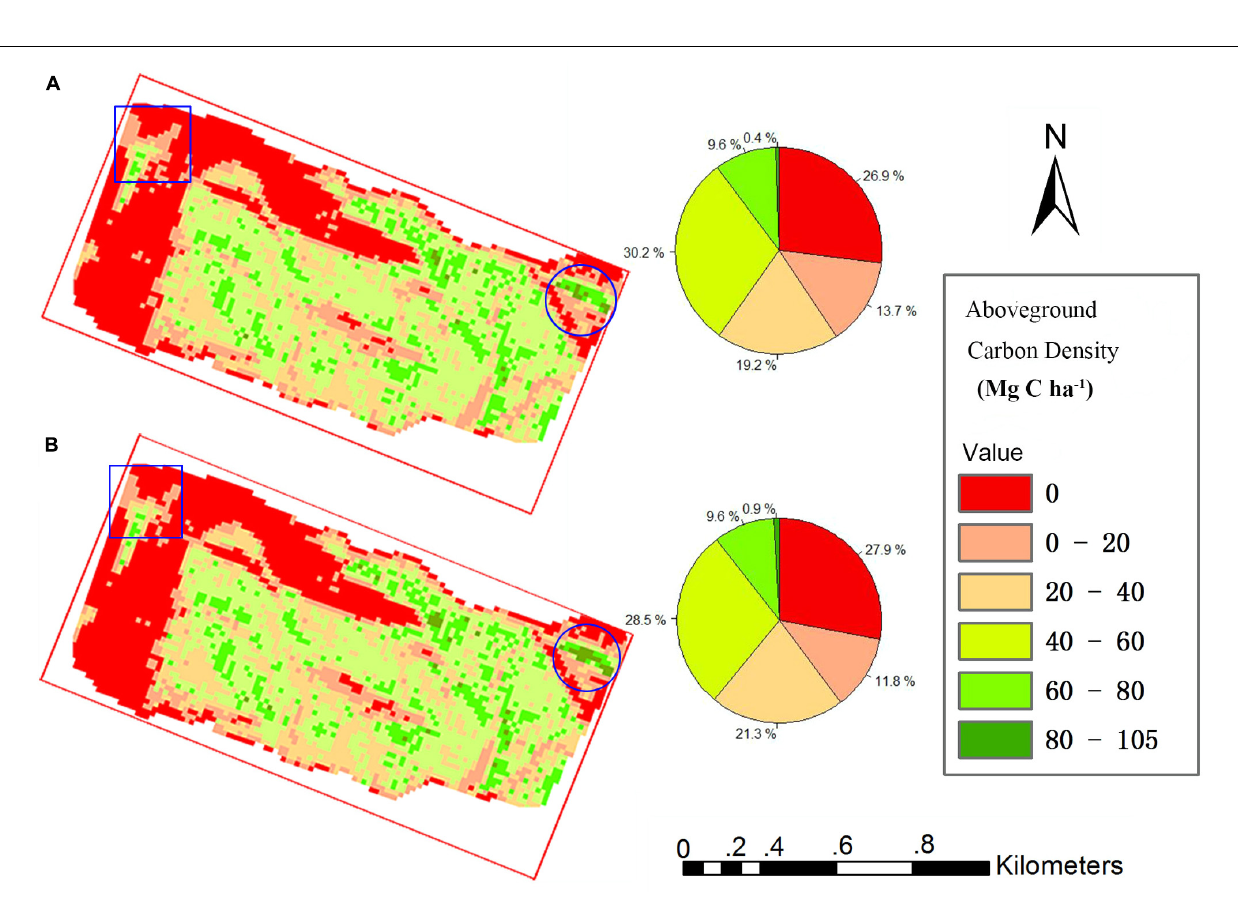
Frontiers in Plant Science |